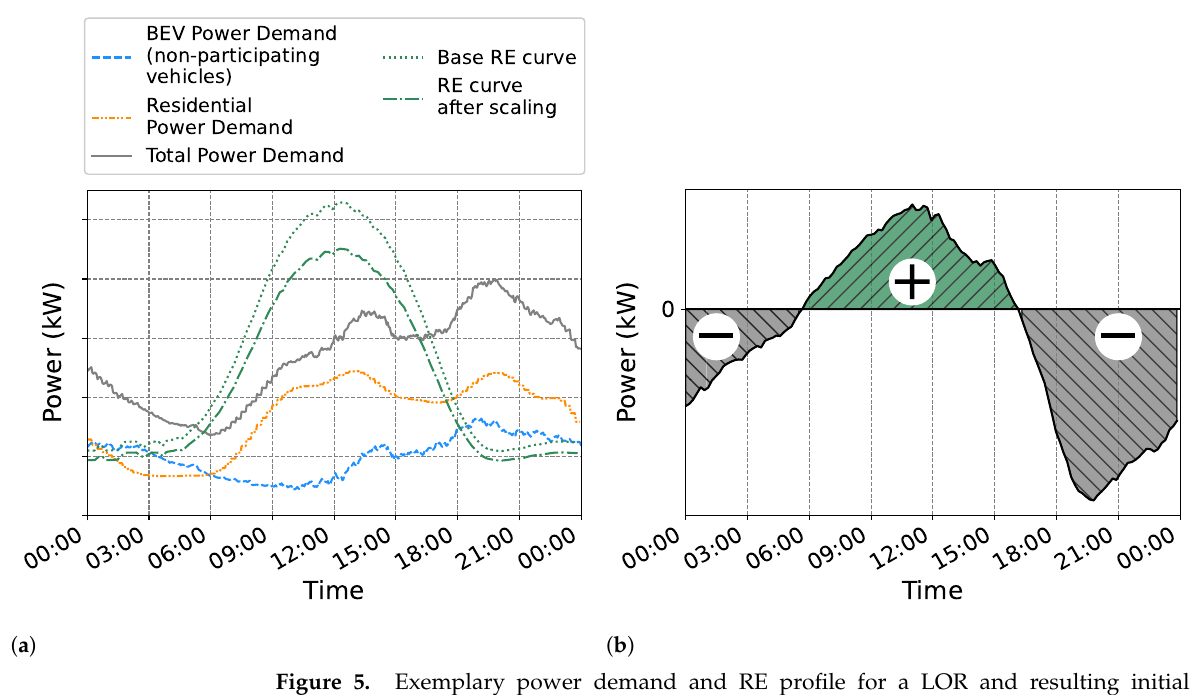
Figure 5. Exemplary power demand and RE profile for a LOR and resulting initial curve for V2G.( a ) Power demand and RE profile for a LOR. ( b ) Initial curve for V2G. The V2G process is a combination of peak-shaving and valley-filling and is performed in step (5) for one BEV at a time. Peak-shaving is used for charging the vehicle. This means that the vehicle is charged at times when the surplus of renewable energy is